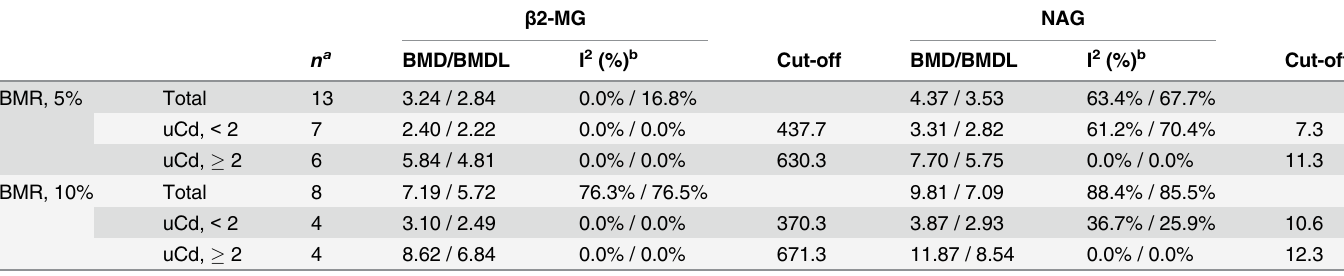
Table 5. Pooled estimates of BMD using studies that reported for both BMDs of β 2-MG and NAG in a